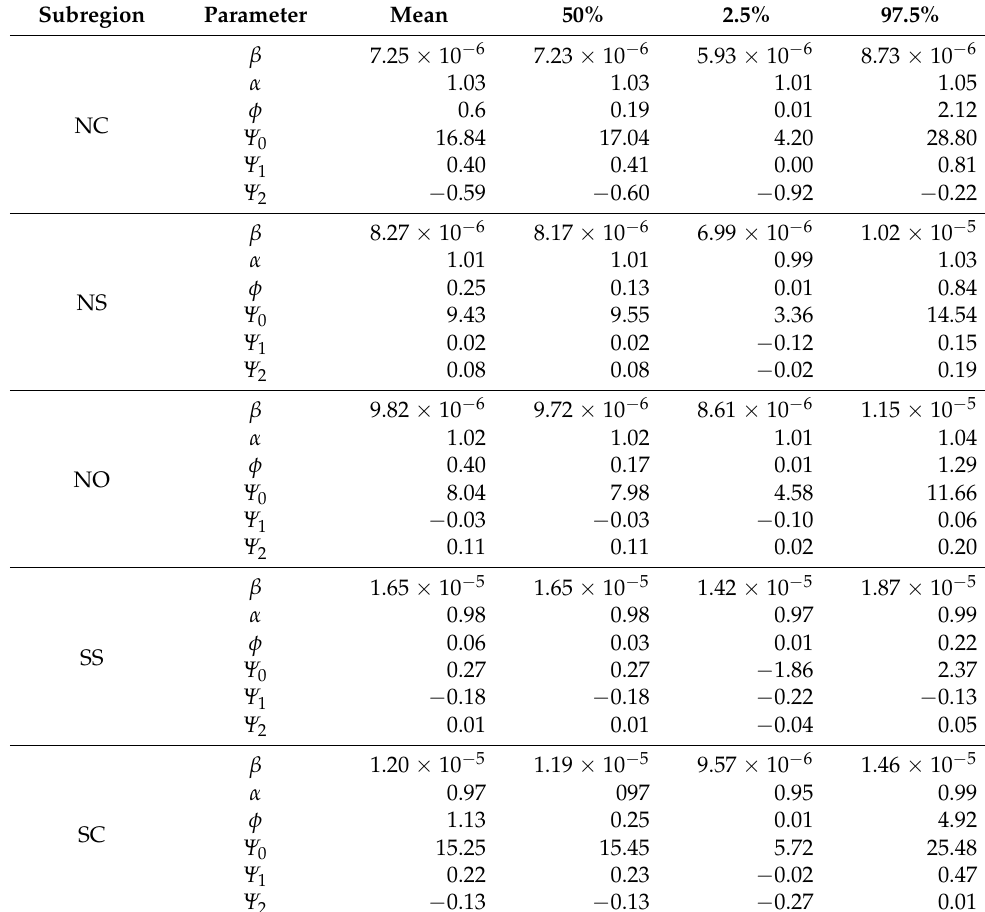
Table 2. Posterior mean, median and 95% credibility interval for the parameters β , α , φ , σ 2 and Ψ (cid:48) = ( Ψ 0 , Ψ 1 , Ψ 2 ) ( Ψ 0 is the intercept, Ψ 1 is the coefficient associated with longitude and Ψ 2 is the coefficient associated with latitude) of the model adjusted for an estimate of the R20 mm index in the NC, NS, NO, SS and SC